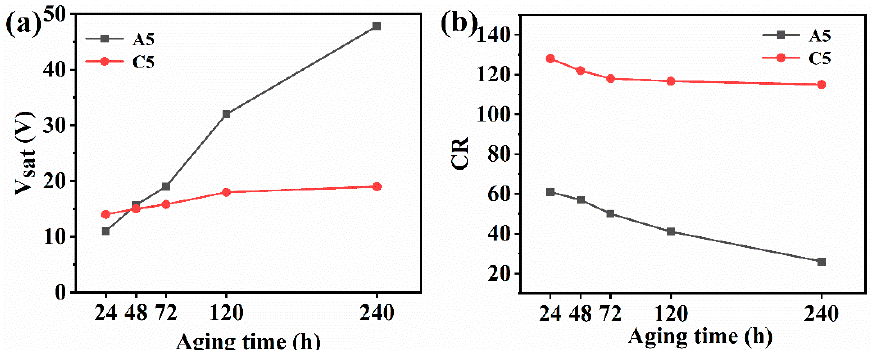
Figure 10. Environmental impacts of extreme air temperature, high relative dampness, and Ultraviolet light on electro-optical e ffi ciency: ( a ) saturation voltage and ( b ) contrast ratio.